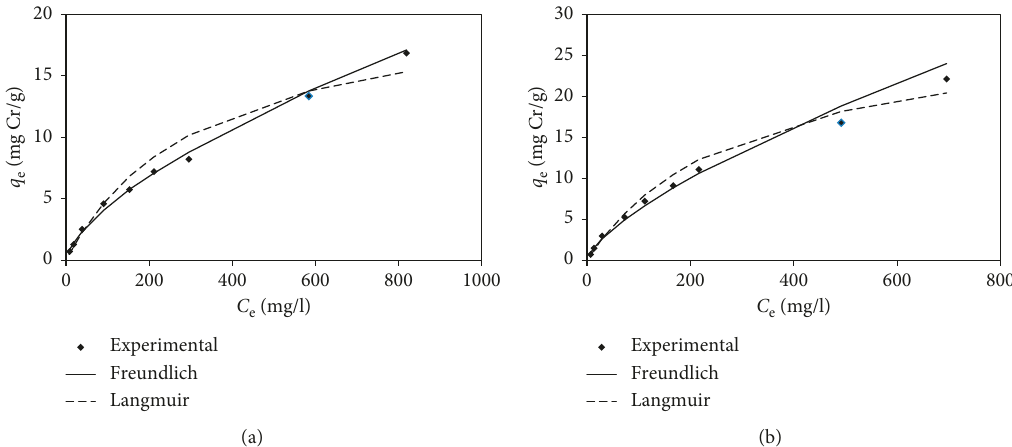
Figure 7: Adsorption of chromium(VI) on CAC at 298K (a) and 323K (b). Solid line: fitting to the Freundlich isotherm; dashed line: fitting to the Langmuir